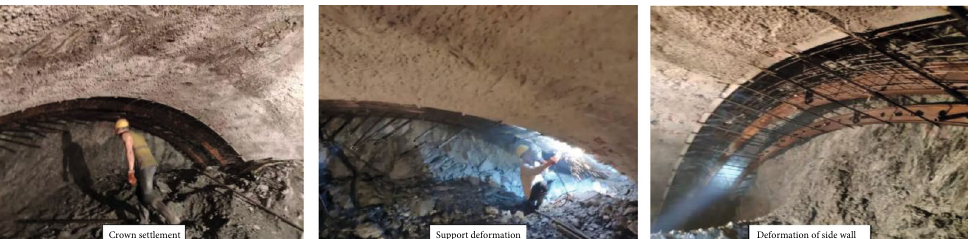
Figure 3: Tunnel deformation.